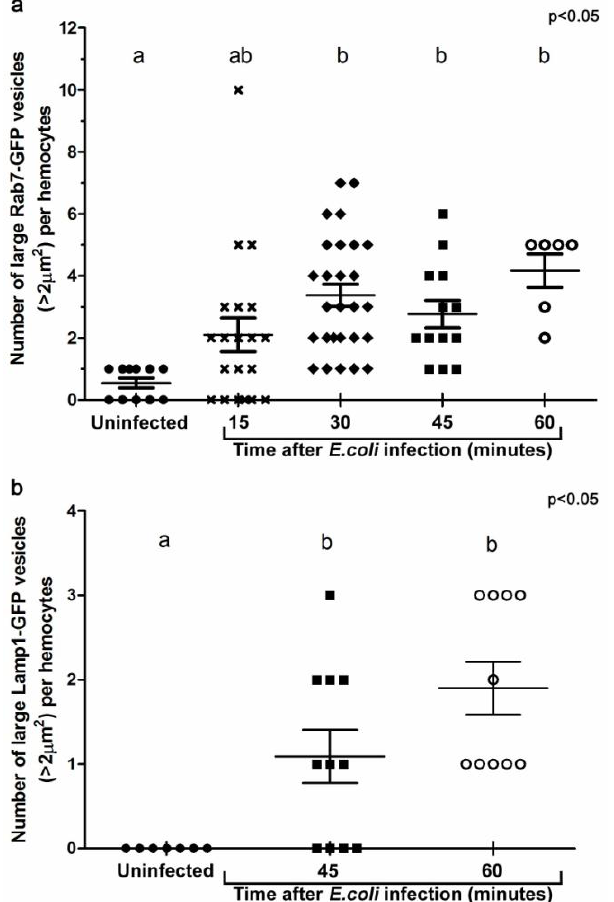
Lamp1-GFP (b) compartments per hemocyte when examined ex vivo at designated time points after in vivo infection. For each group, at least five individual adult female flies were analyzed. Each symbol represents a single hemocyte; and the respective number of vesicles per hemocyte displayed on the Y-axis. The changes in the number of large vesicles per hemocyte is presented as mean±SEM. One-way ANOVA analysis of variance showed significant differences between group means ( P <